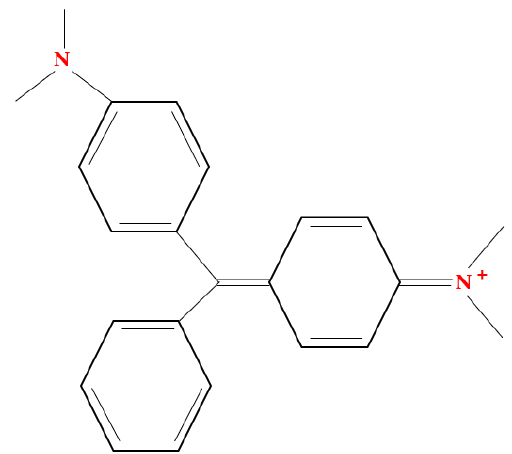
Figure 2. Chemical structure of malachite green (MG).